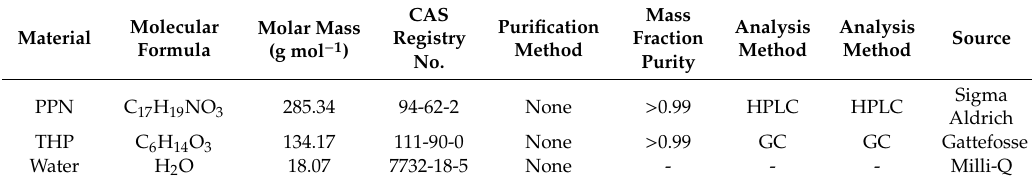
Table 7. List of materials